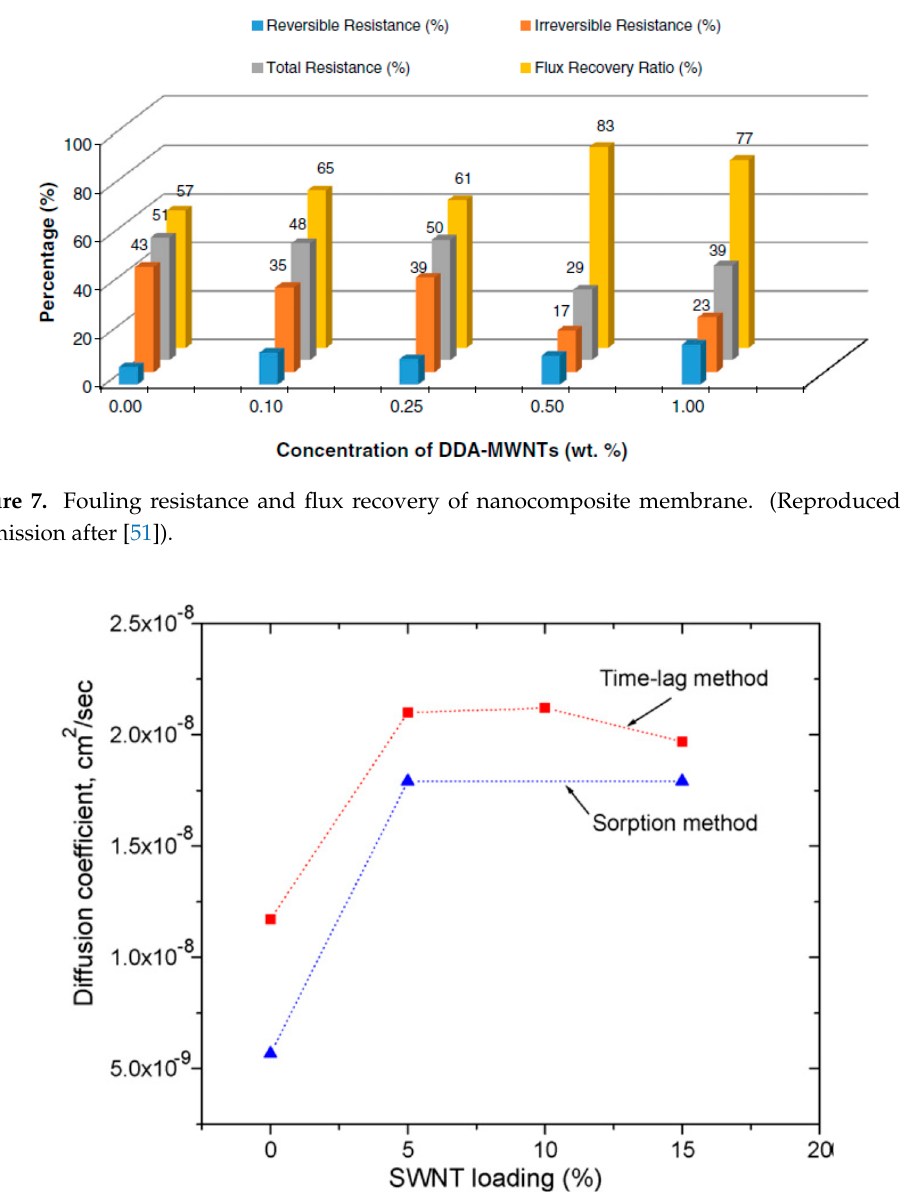
Figure 8. CO 2 di ff usion coe ffi cients in single-walled carbon nanotubes (SWCNT) / PSF mixed-matrix Figure 8. CO 2 diffusion coefficients in single-walled carbon nanotubes (SWCNT)/PSF mixed-matrix membranes (MMMs) at 308 K. (Reproduced with permission after membranes (MMMs) at 308 K. (Reproduced with permission after [54]).